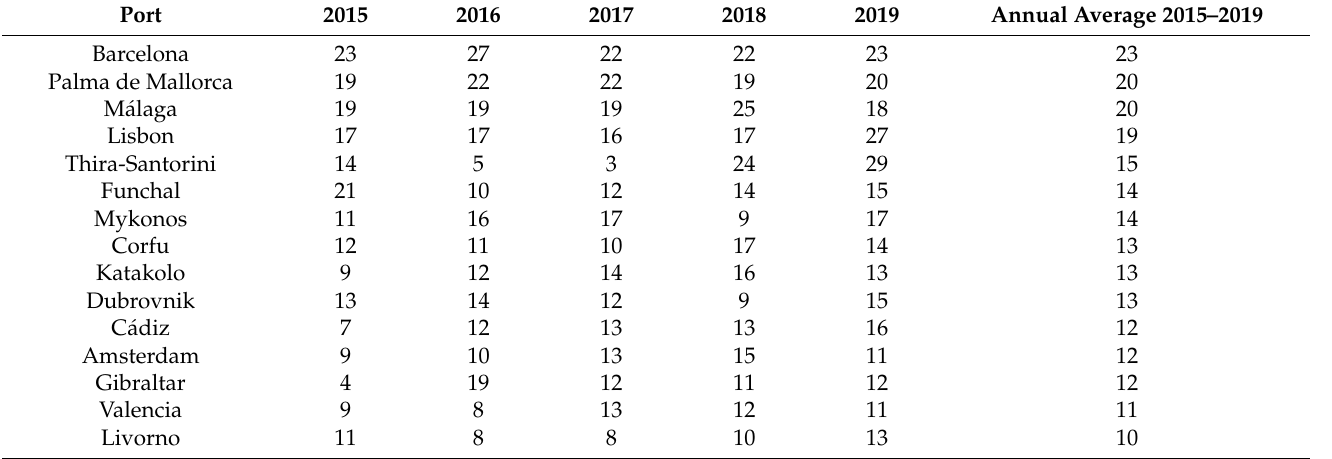
Table 6. Top 15 ports in terms of incoming degree and its evolution from 2015 to 2019 in the contemporary cruise port network in Southern